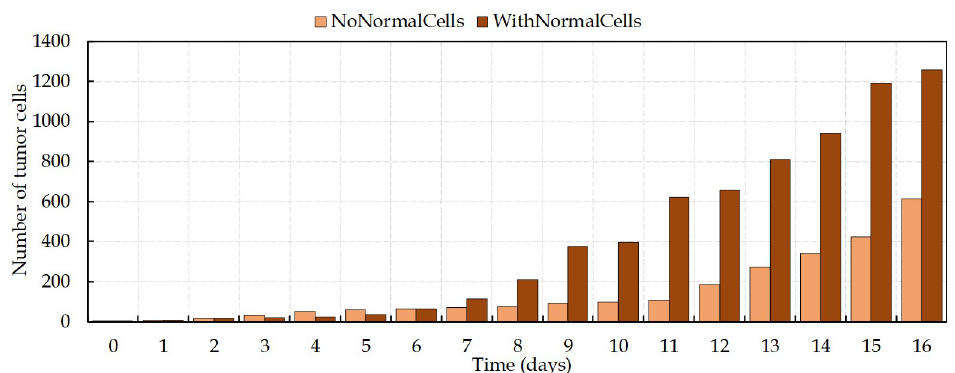
Fig 13. Number of tumor cells in two different conditions, with and without normal cells, of tumor vascular growth.